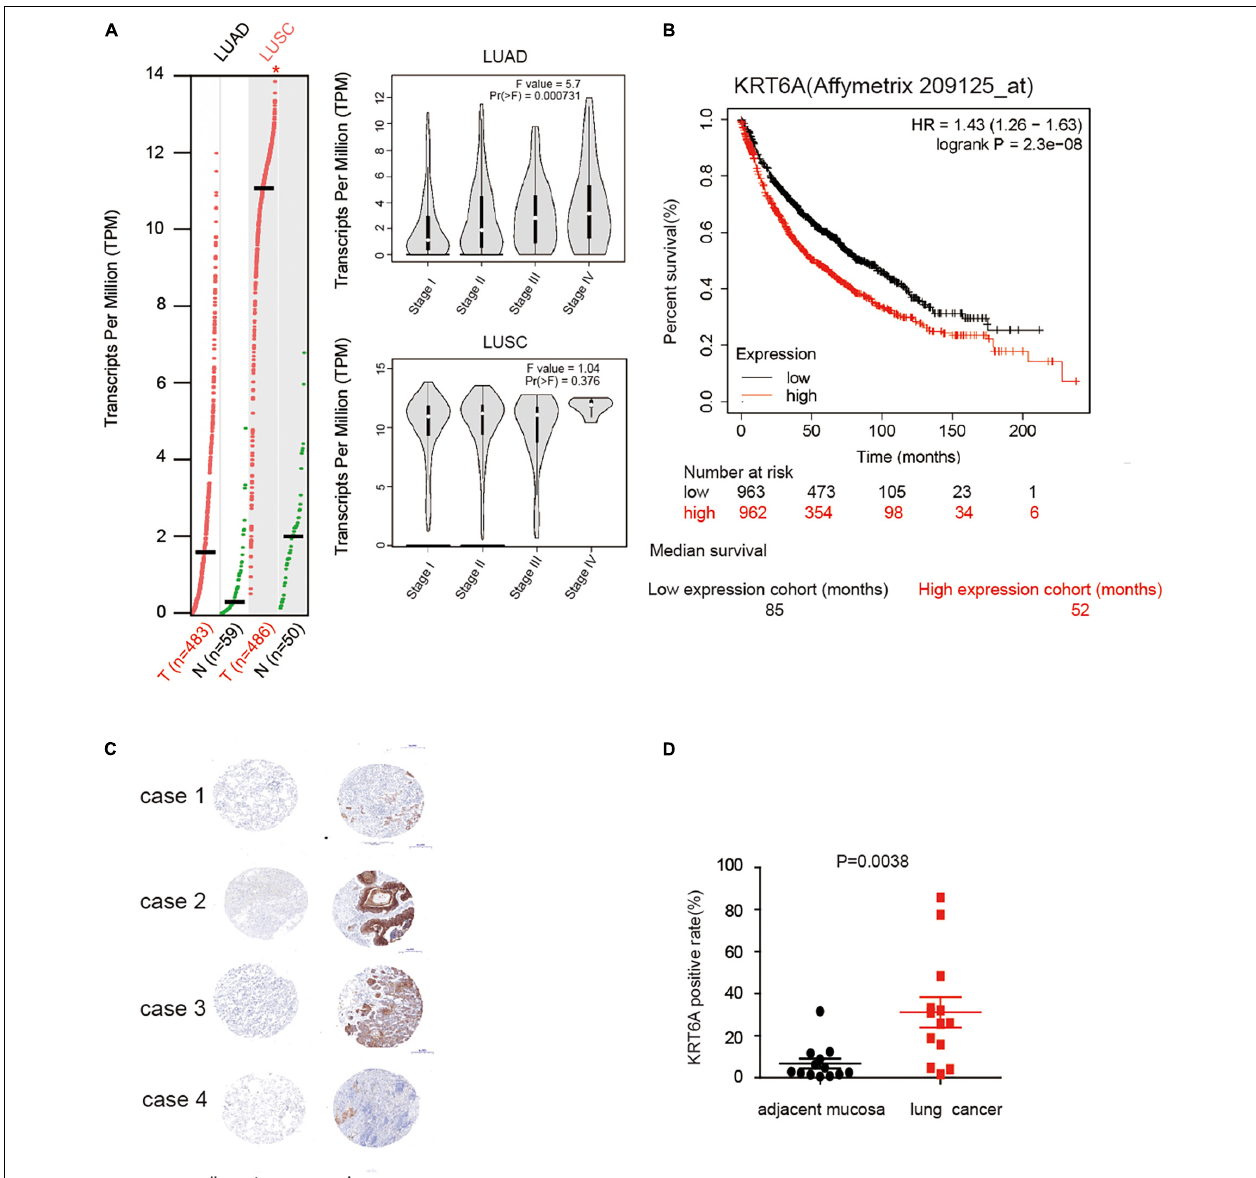
FIGURE 1 | KRT6A is upregulated in NSCLC and associated with patient prognosis. (A) The levels of KRT6A in 483 lung adenocarcinoma and 486 lung squamous carcinoma tissues, and its expression differed according to TNM stages as recorded in (http://gepia.cancer-pku.cn/). (B) Kaplan-Meiers survival analysis of KRT6A expression in lung cancer patients with low and high tumor expression of KRT6A, calculated from (http://kmplot.com/analysis/). The cutoff lines to divide into high and low group was median value. (C) IHC analysis of KRT6A in NSCLC tissues ( × 400). Note low staining of KRT6A in normal tissues and high staining of KRT6A in NSCLC tissues. (D) Quantification of IHC data revealed significantly increased KRT6A expression in NSCLC specimens compared with the adjacent